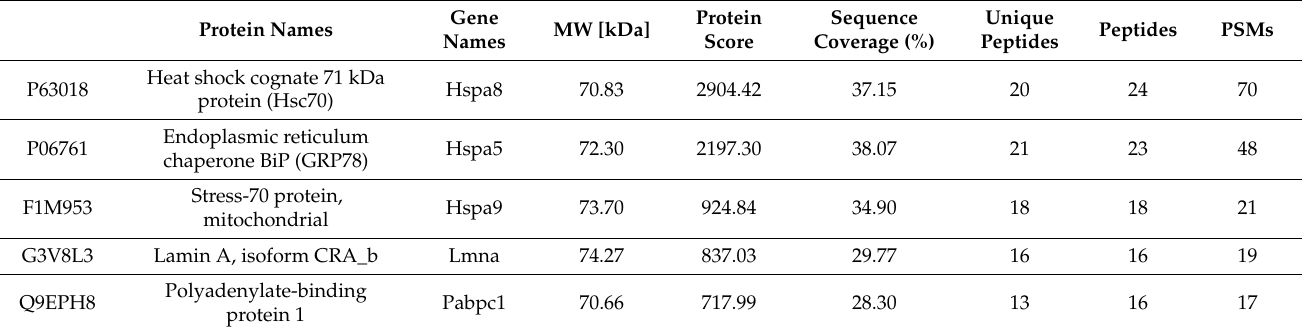
Figure 3. Target identification of ABG-001 by ABPP. ( a , b ) In situ fluorescent labeling of the PC12 cells using different concentrations of ABG-P1 and ABG-PC together with a DMSO treated negative control. ( c ) In situ fluorescent labeling of PC12 cells by treatment with ABG-P1 at different time periods. ( d ) Competition assay by pre-treating the cell lysate with ABG-001 before incubating with the ABG-P1 probes. (1) Control group; (2) ABG-P1 (100 μ M); (3) ABG-001 + ABG-P1 (10 + 100 μ M); (4) ABG-001 + ABG-P1(100 + 100 μ M). The probe-labeled proteomes were visualized by click conjugation to the Cy5-azide tag, SDS gel separation, and fluorescent scanning. Table 1. Protein identification results of the 70 kDa band in Figure